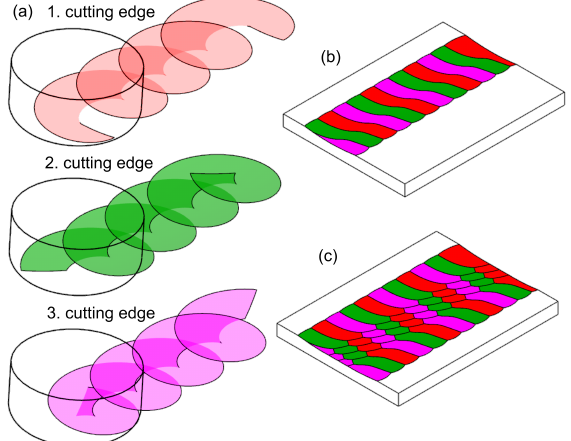
Figure 4. ( a ) Model of the surface of action of individual cutting blades. Surface texture model: ( b ) “one path” ( c ) “several paths”.